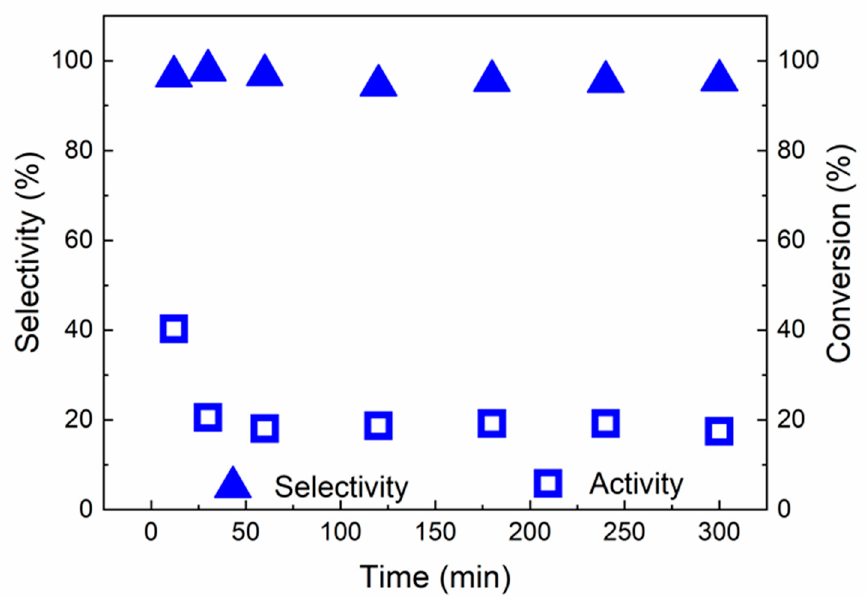
Figure 13. Catalytic behaviour of red(600 °C)-Pd/ γ -Al 2 O 3 in hydrogenation of 2-methy-3-butyn-2- as a function of time on stream at 45 ◦ C and 1 ol as a function of time on stream at 45 °C and 1 bar.